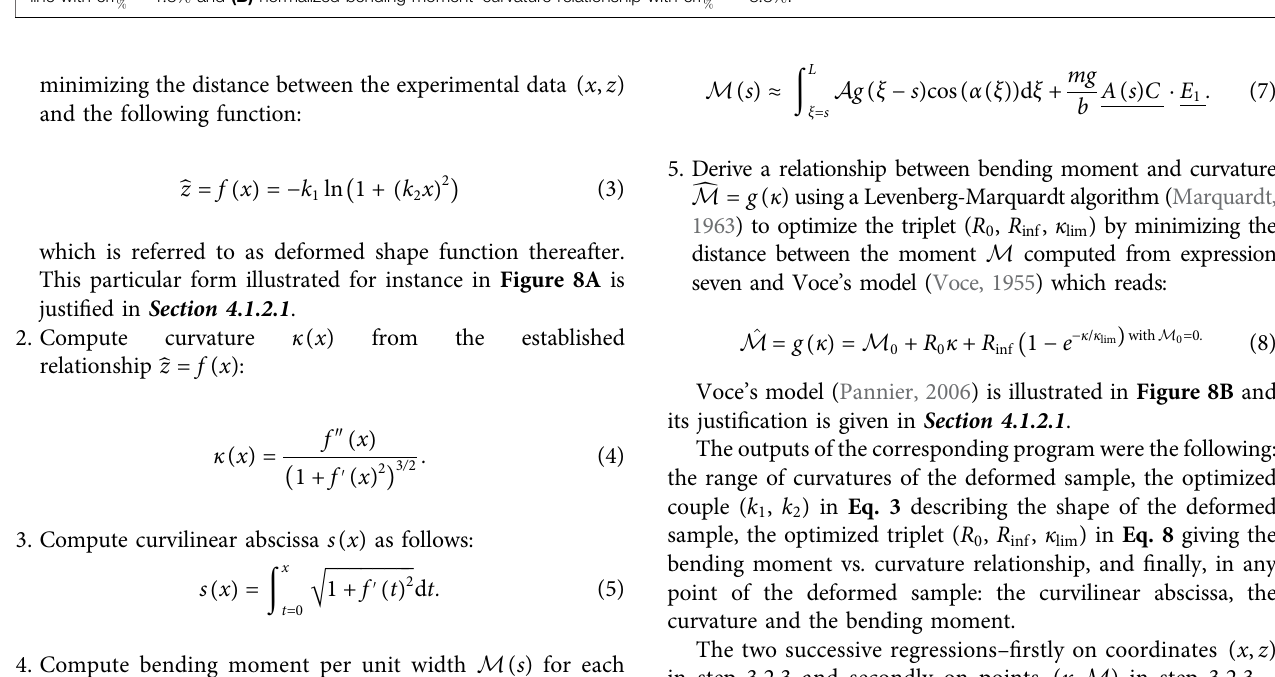
FIGURE 8 | Comparison between experimental data (dashed lines) and model (solid lines) for a single ply tested at room temperature: (A) deformed sample mean line with err ( z ) % (cid:1) 1 . 3 % and (B) normalized bending moment – curvature relationship with err ( M ) % (cid:1) 3 . 8 %